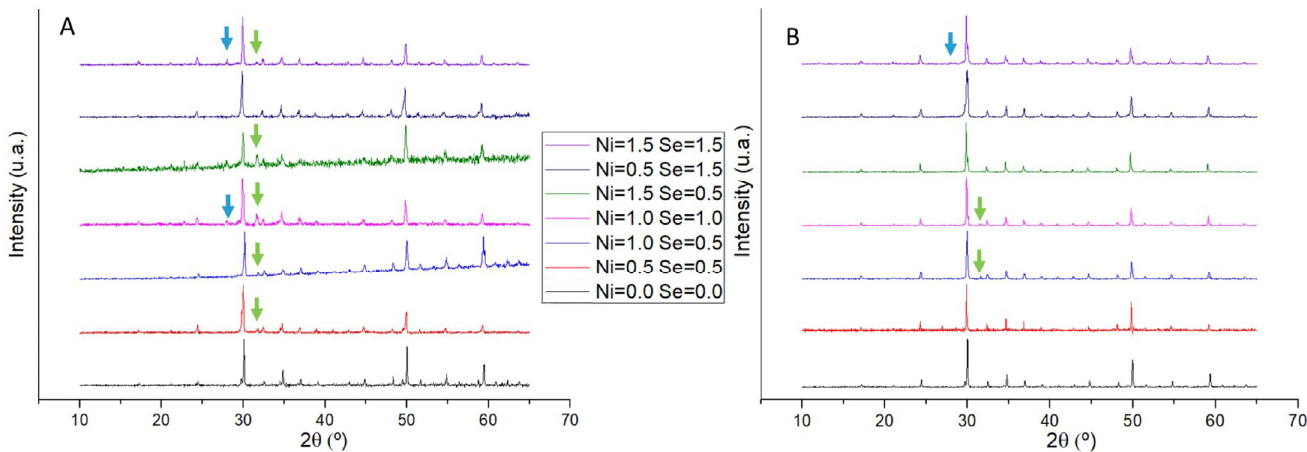
Figure 4. Powder X ‐ ray diffractograms of Cu 12 − x Ni x Sb 4 S 13 − y Se y samples (( A ) as ‐ cast and ( B ) annealed). Arrows indicate peaks of secondary phases: green for covellite (CuS) and blue for famatinite (Cu 3 SbS 4 ).